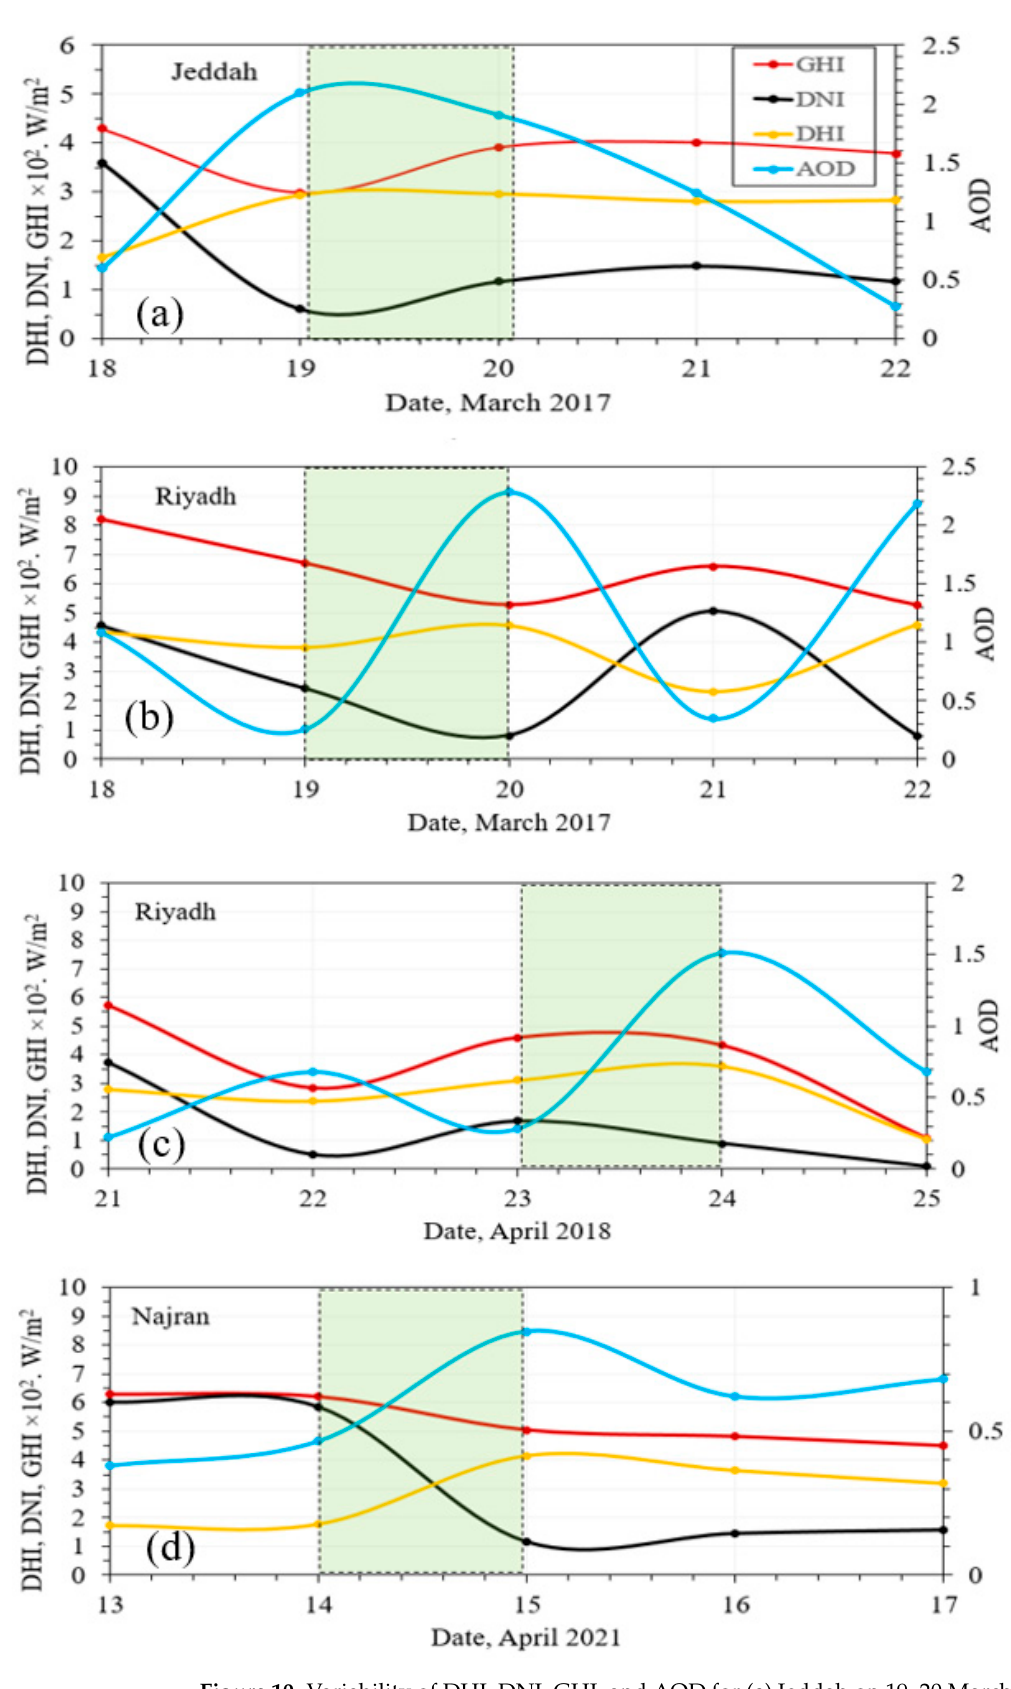
Figure 10. Variability of DHI, DNI, GHI, and AOD for ( a ) Jeddah on 19–20 March 2017, ( b ) Riyadh